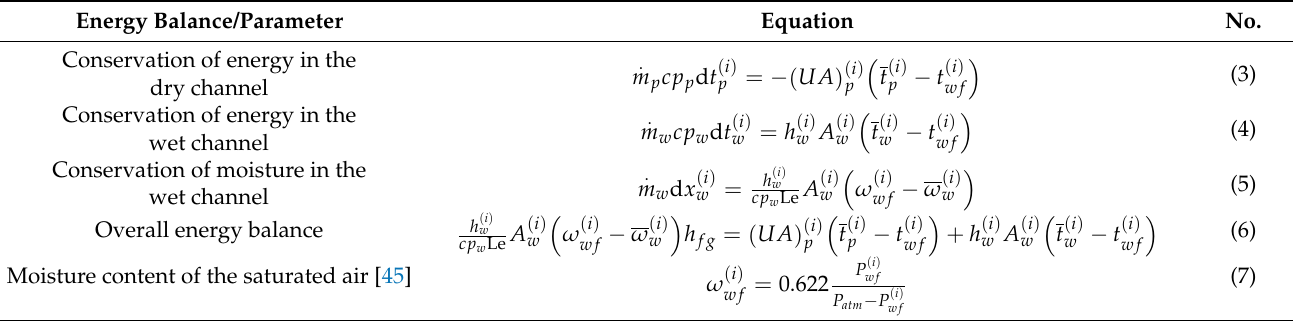
Table 5. Mathematical model equations for GAHP-based